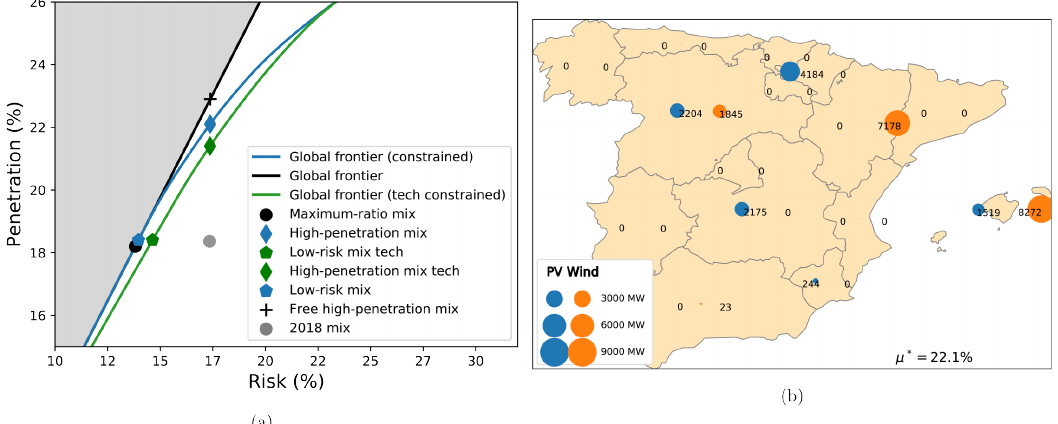
Figure 4. CONOCAL ( a ) penetration-risk diagram and ( b ) high-penetration